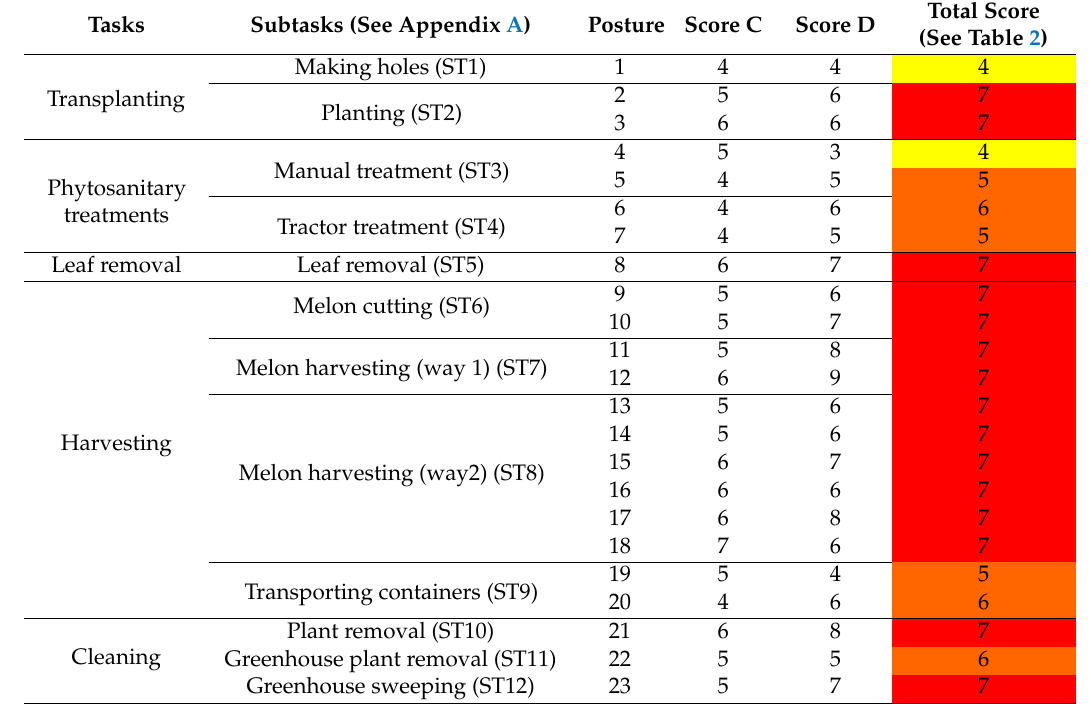
Table 4. Ergomet 3.0 results.